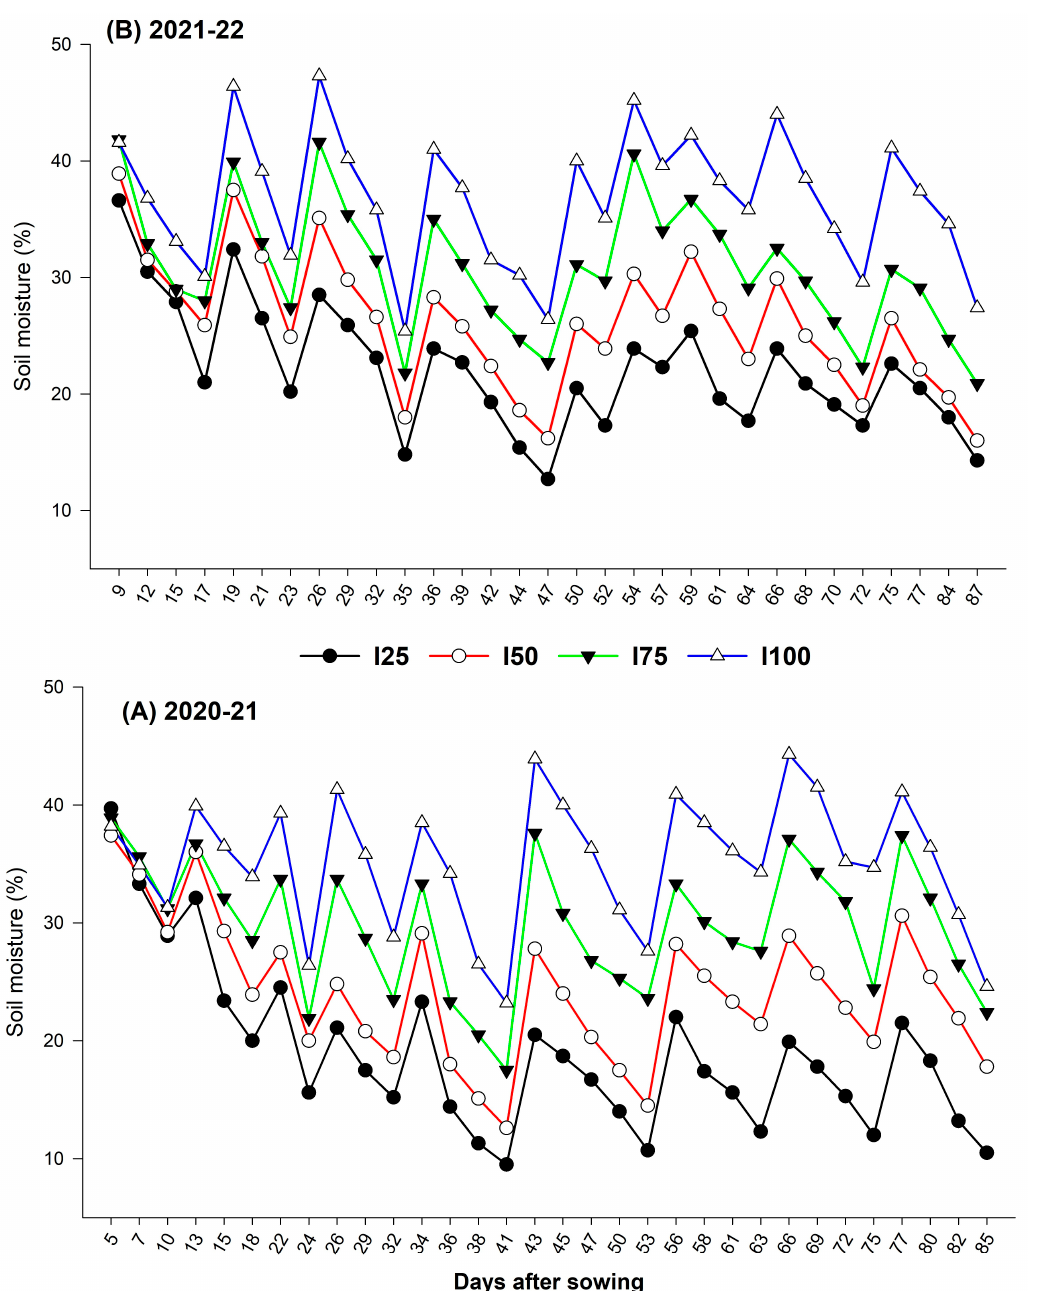
Figure 1. Year–wise soil moisture distribution due to irrigation regimes throughout the chia growth stages.